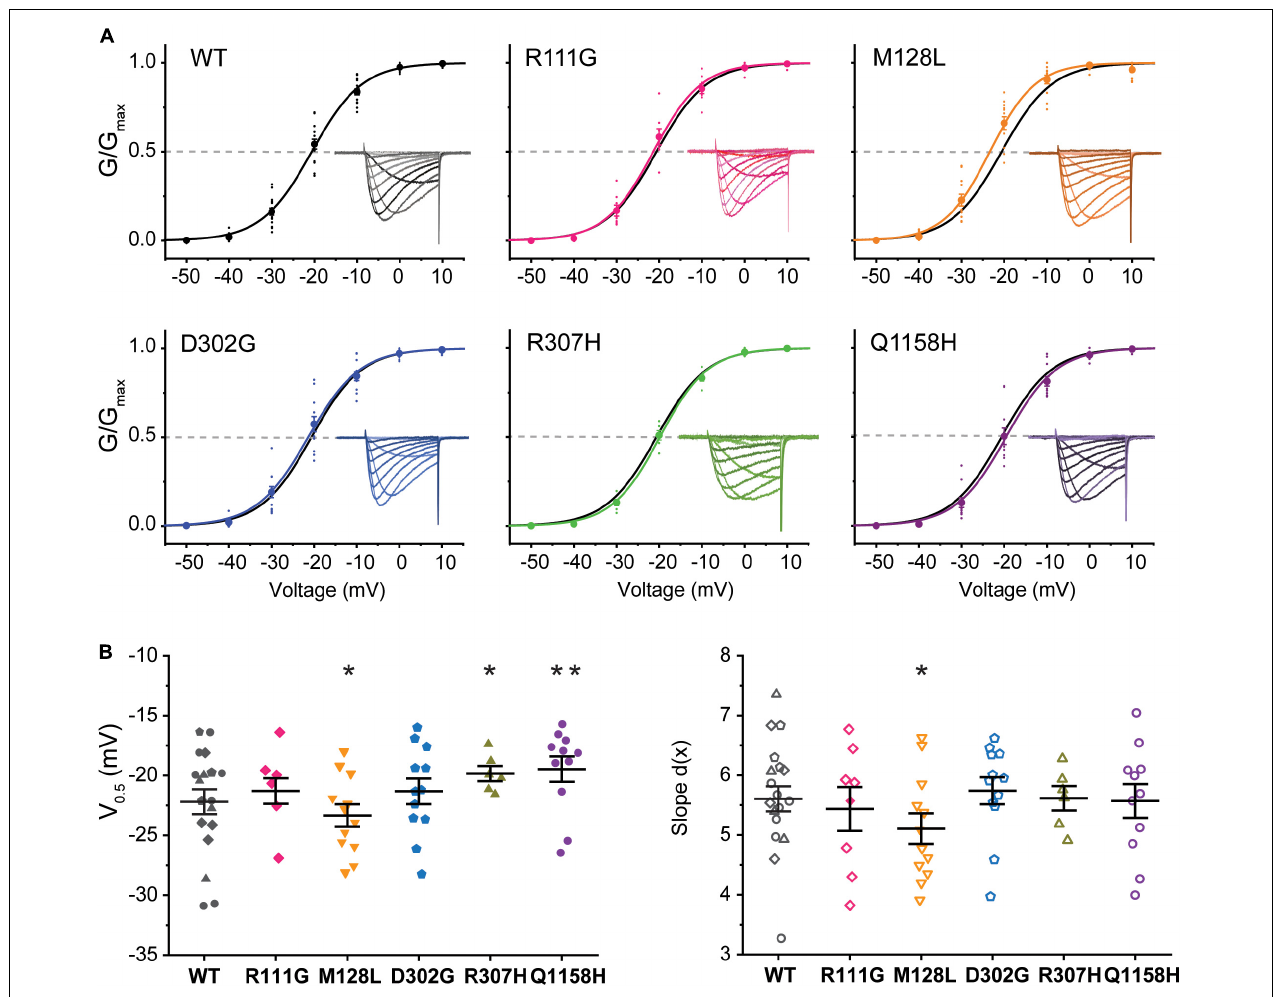
FIGURE 2 | Voltage dependence of activation of Cav3.3 WT and HM-associated variants. (A) Normalized conductance (G/G max ) vs. voltage relationships for Cav3.3 and HM variants. Representative current families are included as insets. Dotted lines are drawn at G/Gmax = 0.5 to highlight the voltage of half-maximal